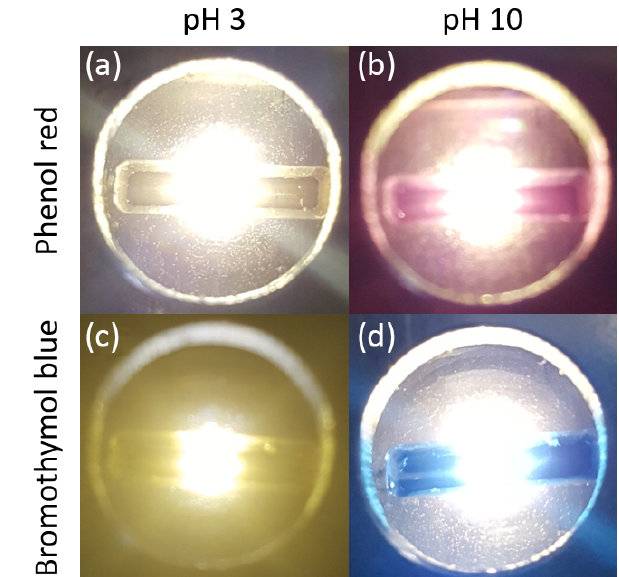
Figure 9. Pictures of the LED shining through the reactor mock-up filled with PhR (a, b) and BTB (c, d) in pH 3 (Left column) and pH 10 (right column). Pictures were taken from above while the RGB sensor of prototype II was dismounted.